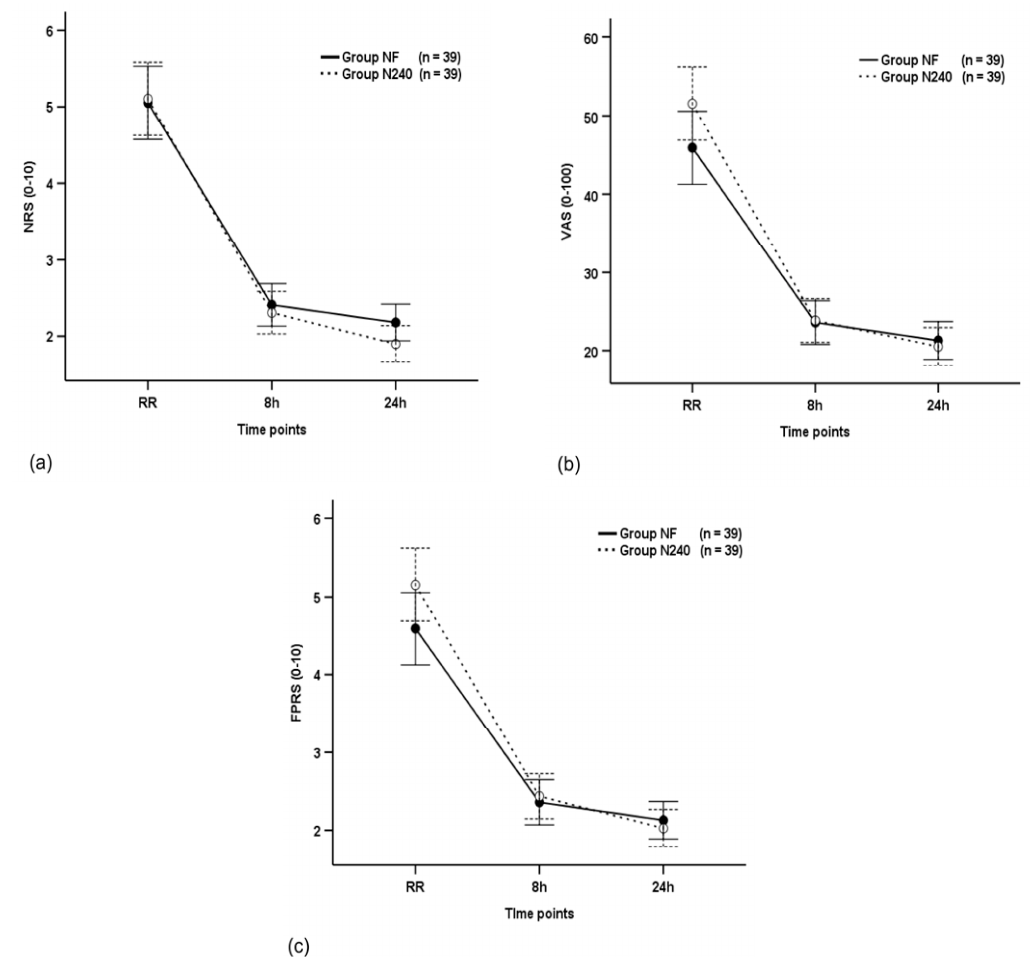
Figure 2. Time-sequential changes in numeric rating scale (NRS) scores ( a ), visual analogue scale (VAS) scores ( b ), and Faces Pain Ratings Scale (FPRS) scores ( c ). Data points and error bars represent means and 95% confidence intervals, respectively. Group NF, group receiving nefopam-fentanyl polytherapy; Group N240, group receiving nefopam monotherapy; RR, 30 min after admission to the recovery room. Figure 2b). The VAS scores of group N240 (23.59) were non-significantly different to group NF (23.85) at 8 h postoperatively ( p = 0.897; Figure 2b). The FPRS scores were not significantly different between the groups throughout the postoperative period ( p = 0.136), and they decreased with time in both groups ( p < 0.001; Figure 2c). The FPRS scores of group N240 (2.36) were non-significantly different to group NF (2.44) at 8 h postoperatively ( p = 0.709; Figure 2c). 3.4. Bolus Demand Count and Bolus Infused Count The bolus demand count and bolus infused count were not significantly different between groups throughout the postoperative period ( p = 0.270 and p = 0.871, respectively; Figure 3a and 3b), and decreased with time in both groups ( p < 0.001 and p = 0.005, respec- tively; Figure 3a and 3b).